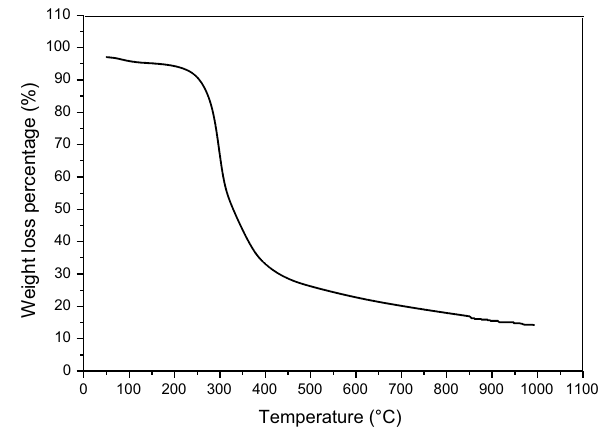
Fig. 1 TGA curve of natural